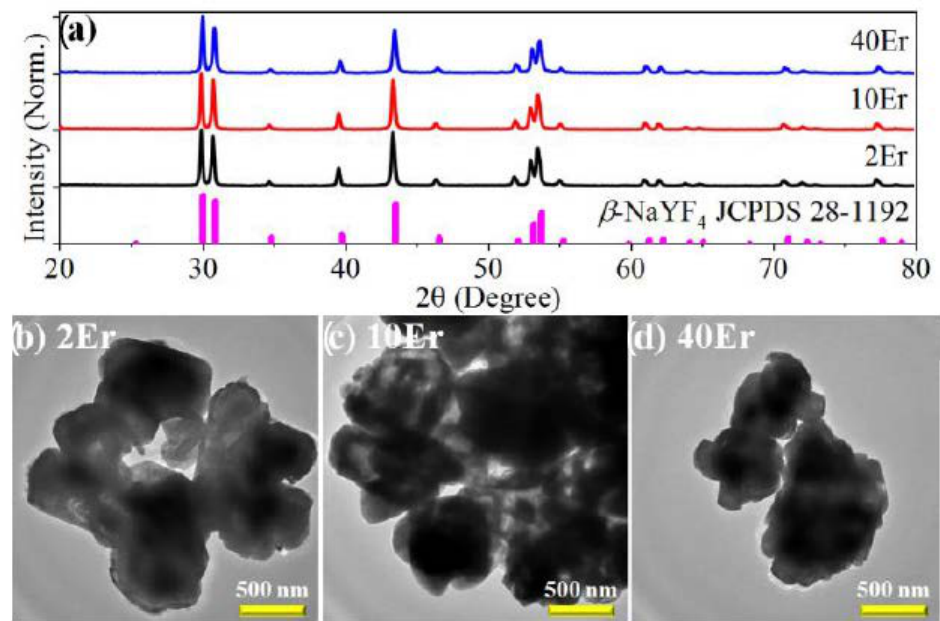
Figure 2. Structural characterizations of typical samples. ( a ) XRD patterns with standard diffraction data of β -NaYF4 as a reference; ( b – d ) TEM images of the samples. Scale bars are all 500